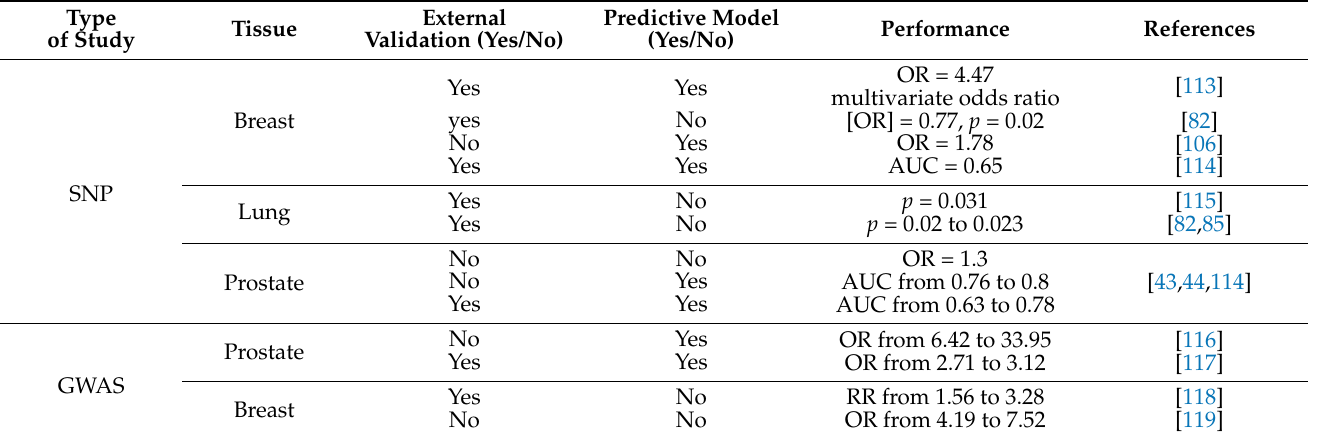
Table 4. Genome-wide association studies (GWAS) and significant polymorphisms associated with